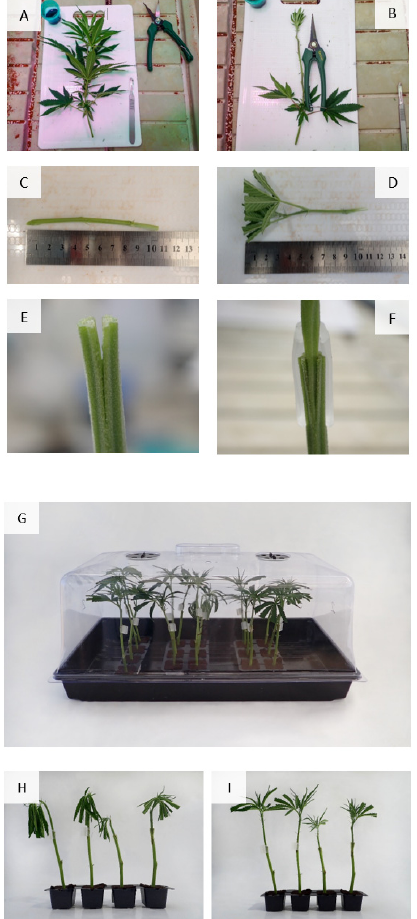
Figure 1. Grafting methodology. ( A ) Two stems were cut from donor mother plants. An example is shown in A. One stem to form the scion and the other the rootstock. ( B ) The top leaf bunch was retained on the scion stem, it was trimmed then all other leaves were removed. ( C ) The rootstock stem was cut with a scalpel at a slight diagonal angle across a node and the 1 cm area of stem around the node is gently scraped with the scalpel. The top of the stem is cut to result in a 10 cm length section. ( D ) The scion stem is also cut to a 10 cm section using a scalpel and opposite sides of the stem are shaved to form a pencil shape. ( E ) A 1 cm incision is made into the top of the rootstock stem section. ( F ) The scion is slotted into the stem section, the stem surrounding the union is gently wiped with a tissue imbibed with 70% ethanol, and the union is secured using a silicone grafting clip. ( G ) Grafted clones are placed in a propagation dome at 100% humidity. ( H ) Immediately after grafting, the plants will show considerable wilting *. ( I ) Forty eight hours after grafting the plants have regained turgor *. * Plants were only removed from the propagation domes for the purpose of